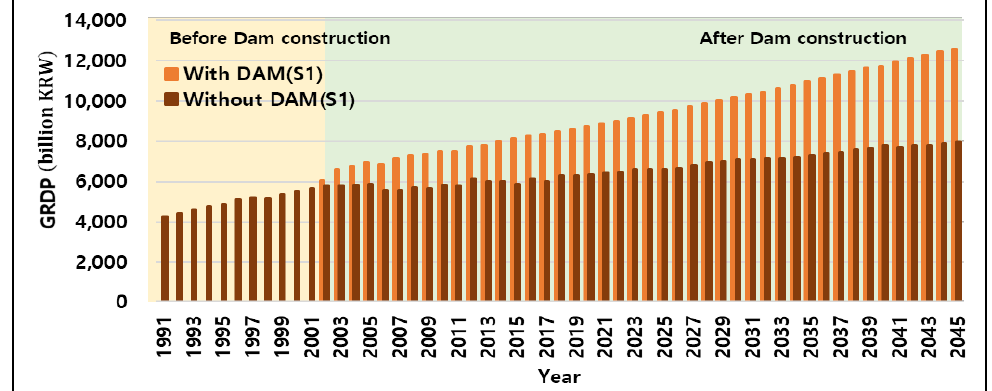
Figure 11. Gross regional domestic product (GRDP) comparison between the With DAM and Without DAM simulations for Scenario 1.